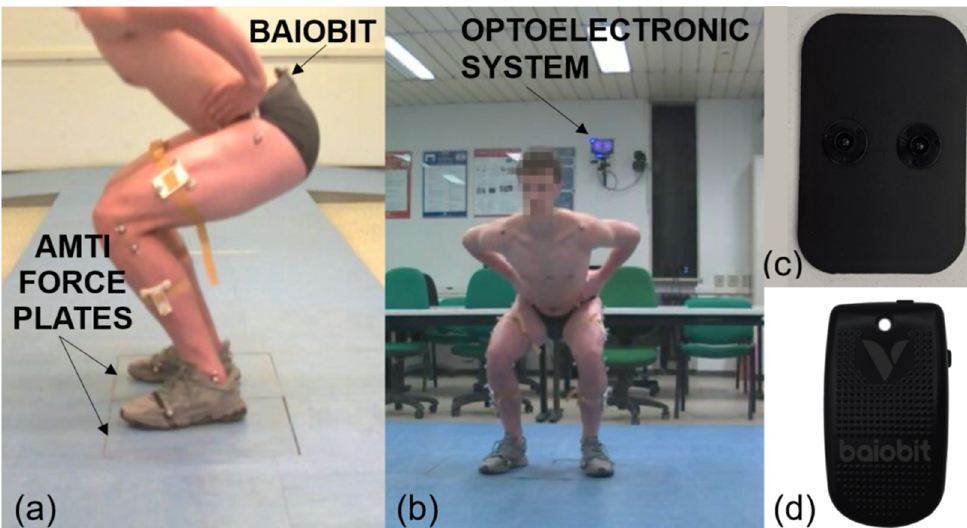
Figure 2. ( a ) Double-leg CMJ frame of the sagittal plane from the optoelectronic system with visible AMTI force plates; ( b ) double-leg CMJ frame of the frontal plane form the optoelectronic system with visible cameras; ( c ) bioadhesive plate; ( d ) Baiobit sensor (Rivelo Srl—BTS bioengineering Group, Milan, Italy).